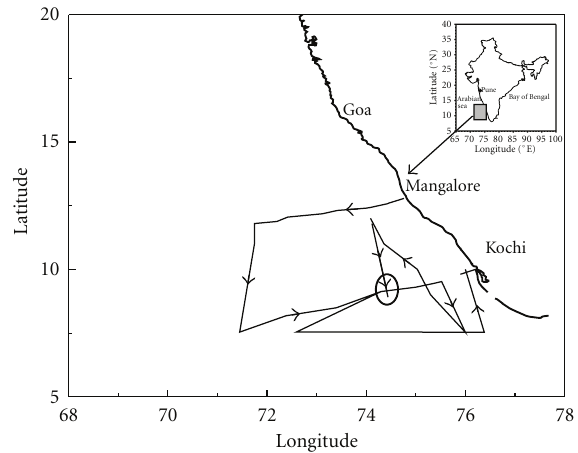
Figure 1: Cruise track of ORV Sagarkanya during the period from May 16, 2003 to June 19,